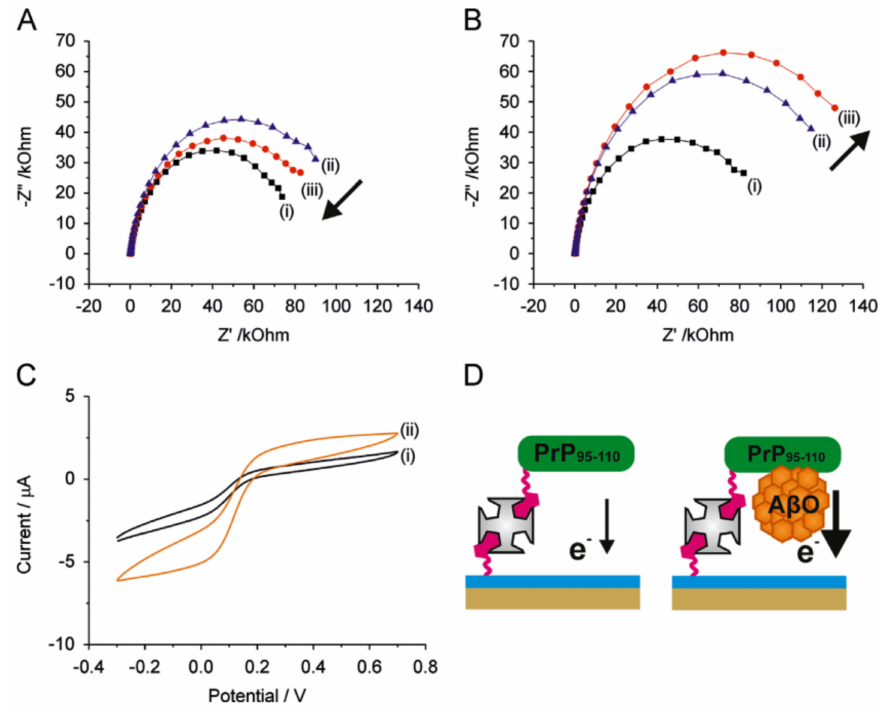
Figure 8. ( A , B ) EIS plots. ( C ) CV study of the biosensor towards A β O. ( D ) Diagram showing an increase in the surface conductivity due to A β O. Reproduced from Reference [80] with permission. Copyright 2014,